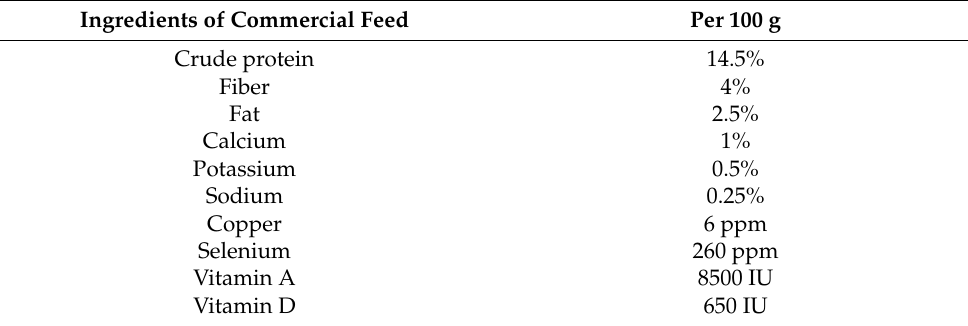
Table 1. Ingredients (%/100 g) of commercial feed.